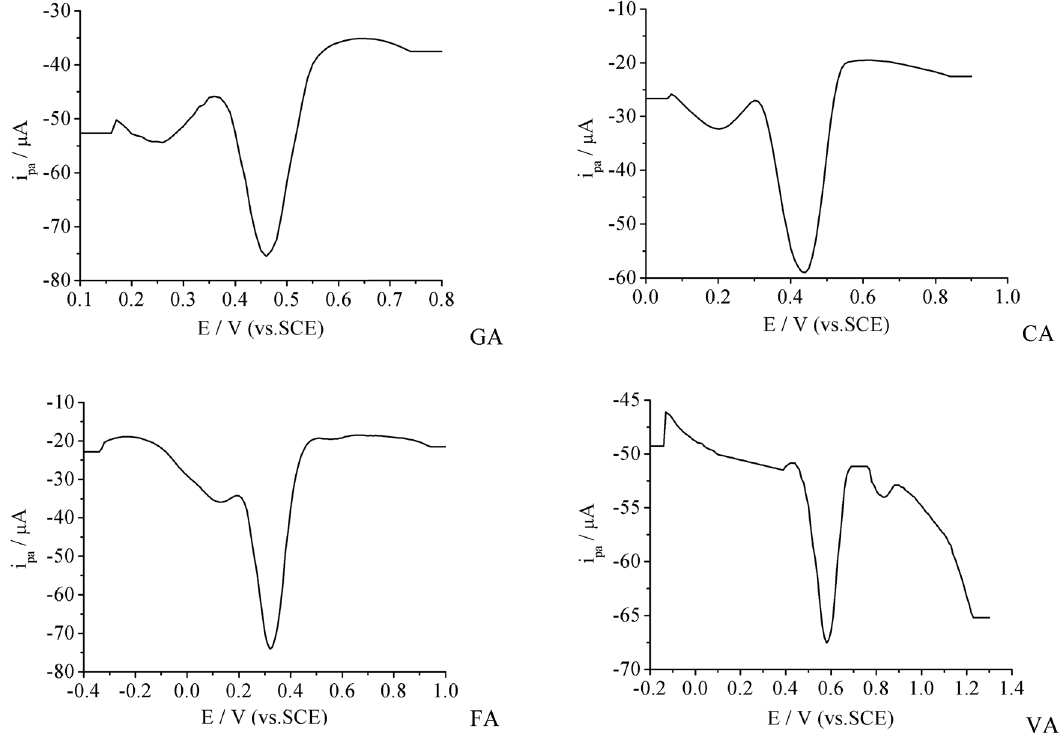
Figure 2: The DPV curve of four polyphenolic compounds on the